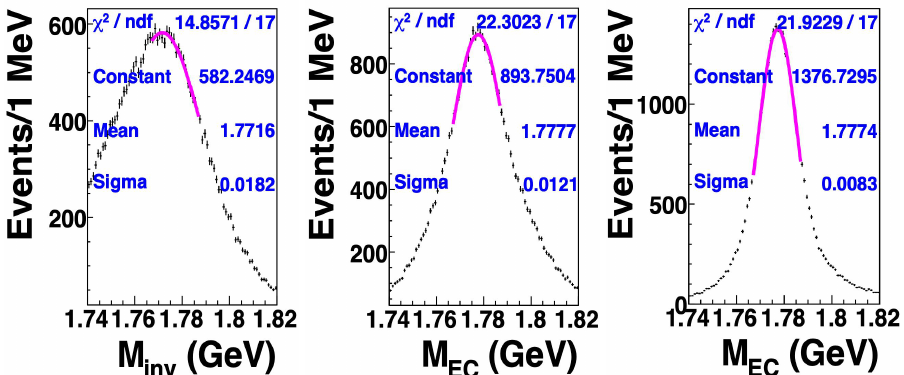
Figure 2. Invariant mass ( left ), m E C without vertex constraint ( middle ) and m E C with vertex con- straint ( right ) obtained from simulated samples during analysis strategy development studies for τ − → µ − γ search at the B A B AR experiment